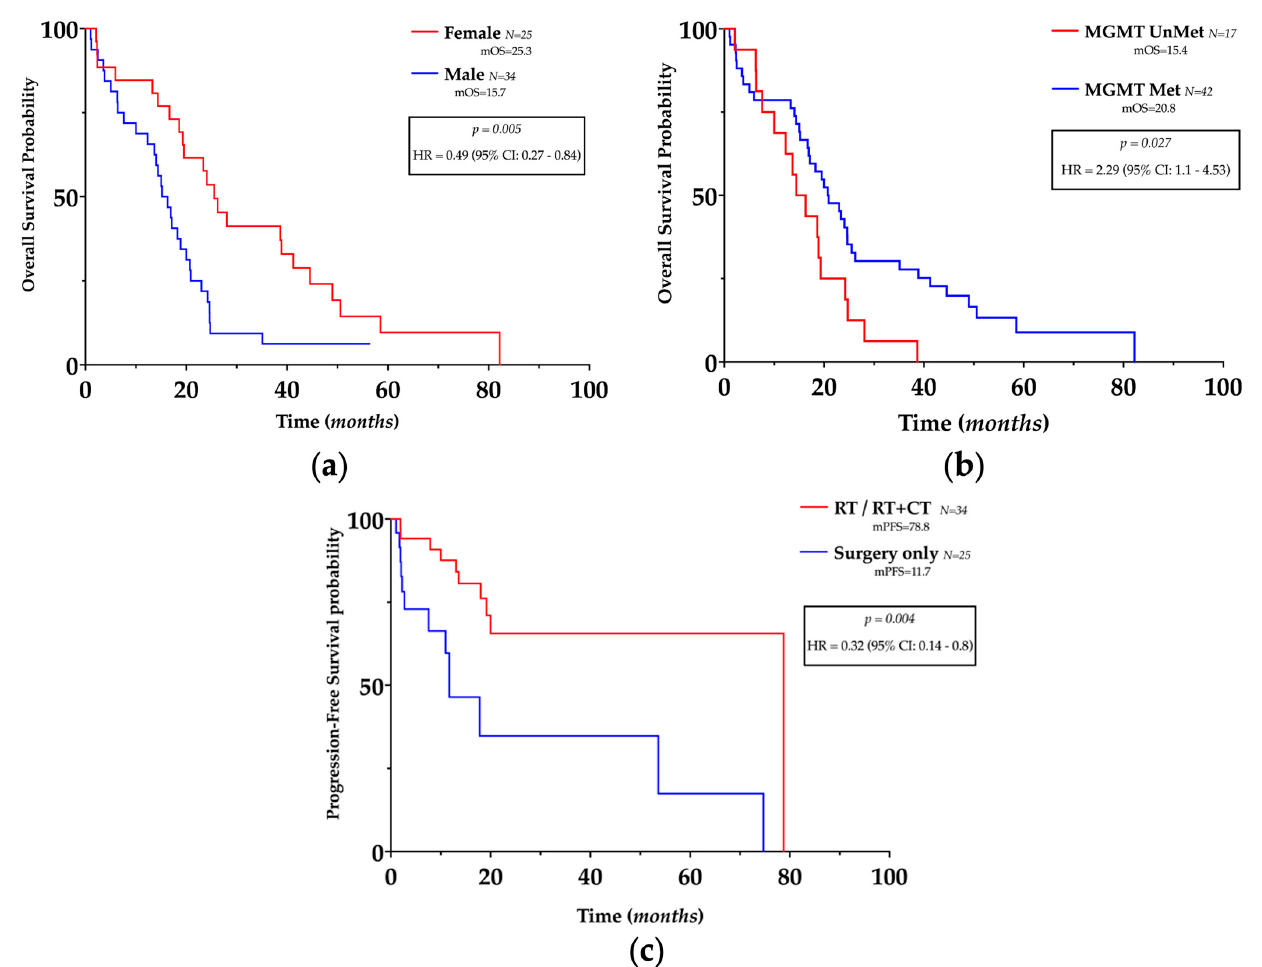
Figure 2. Prognostic impact of clinicopathological features in glioblastoma. ( a , b ) Kaplan–Meier plots of overall survival, according to gender and MGMT promoter methylation status. ( c ) Kaplan–Meier plots of progression-free survival according to treatment.